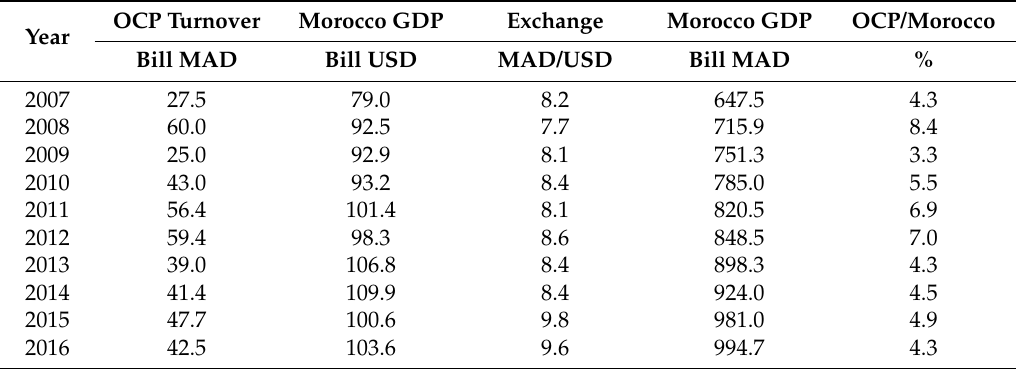
Table 2. OCP’s contribution to the Moroccan GDP (OCP turnover based on annual company reports, GDP based on tradingeconomics.com, and exchange rates based on